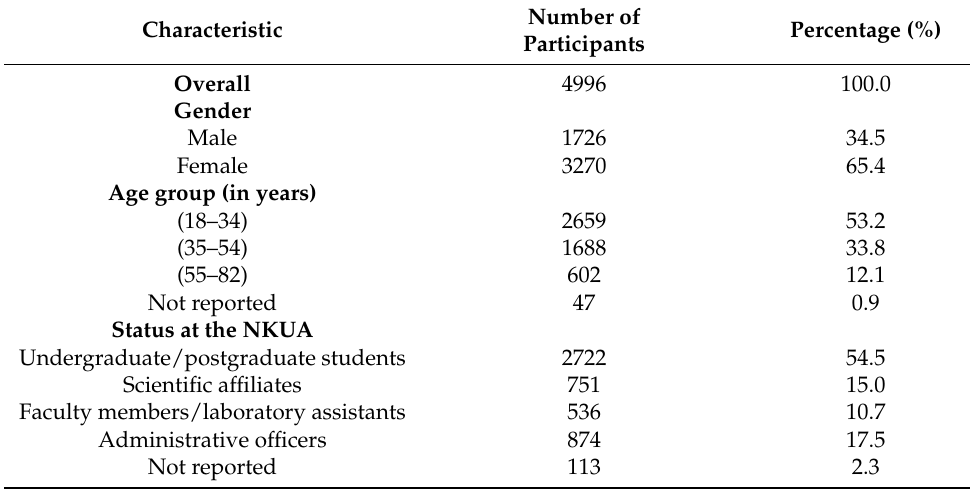
Table 1. Study population and sociodemographic